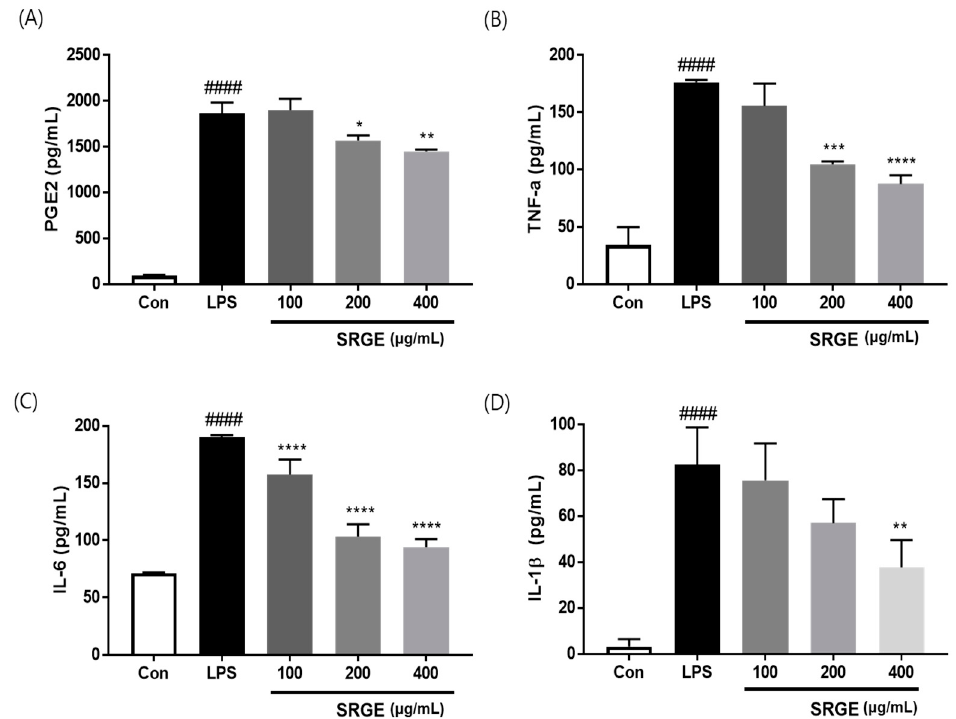
Figure 3. Effect of SGRE on inflammatory mediator and cytokine production in LPS-stimulated Figure 3. E ff ect of SGRE on in fl ammatory mediator and cytokine production in LPS-stimulated RAW264.7 macrophages. ( A ) PGE2, ( B ) TNF- α , ( C ) IL-6, and ( D ) IL-1 β production in the culture media was quantified using ELISAs. #### p < 0.0001 vs. control cells. * p < 0.05; ** p < 0.01; *** p < 0.001; **** p < 0.0001 vs. LPS-treated